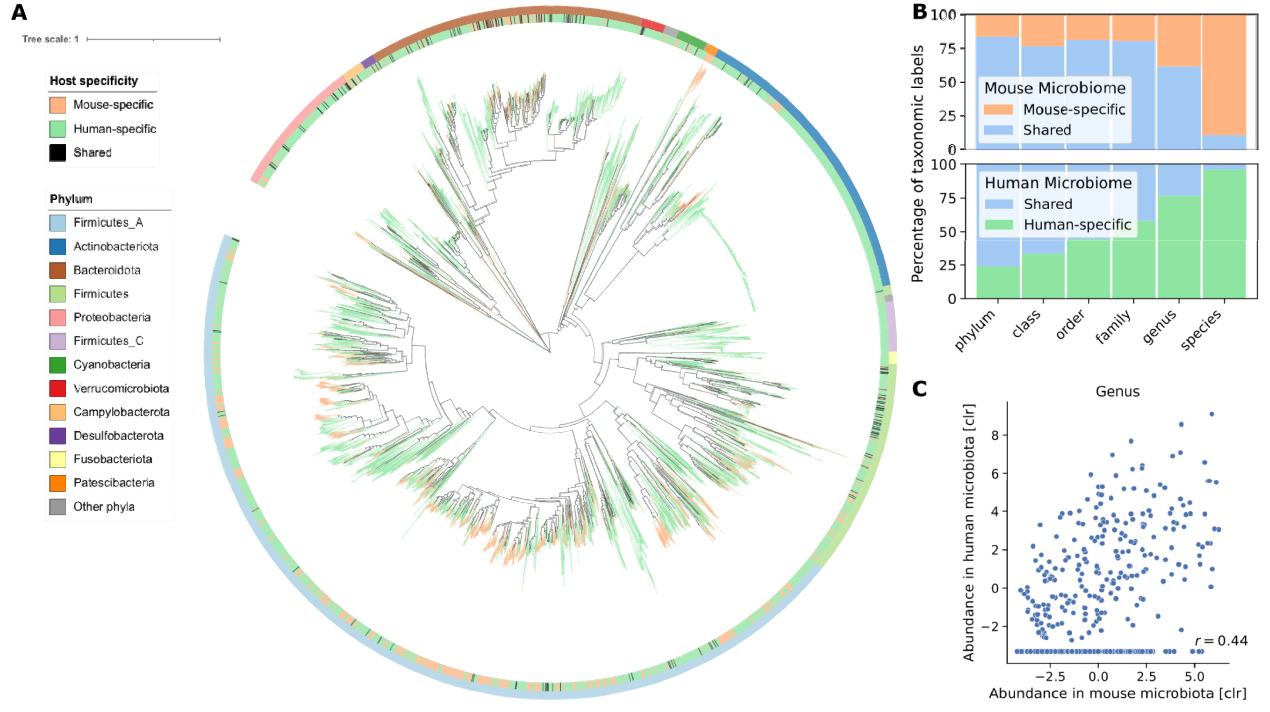
Fig 4. Human and mouse guts harbor distinct bacterial species. | (A) Maximum-likelihood phylogenetic tree of the bacterial species from UHGG and CMMG. The innermost color ring and the tree branches are colored by host specificity. The outermost color ring indicates the phylum attribution. (B) Percentage of shared and host-specific taxa from CMMG and UHGG at different taxonomic levels. (C) Correlation of average abundance of genera in human and mice microbiotas. For genera detected in mouse but not in human we imputed the lowest value measured. CLR = centered log ratio.